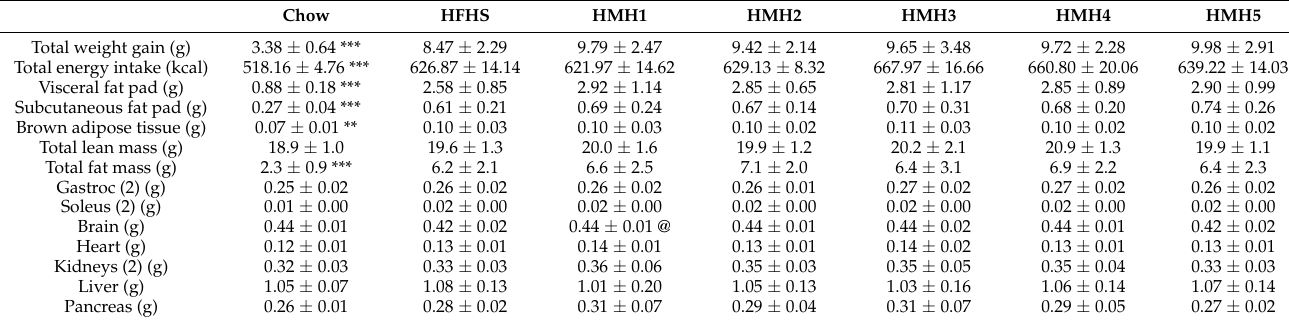
Table 2. Effects of HMHs’ supplementation on mice body characteristics.